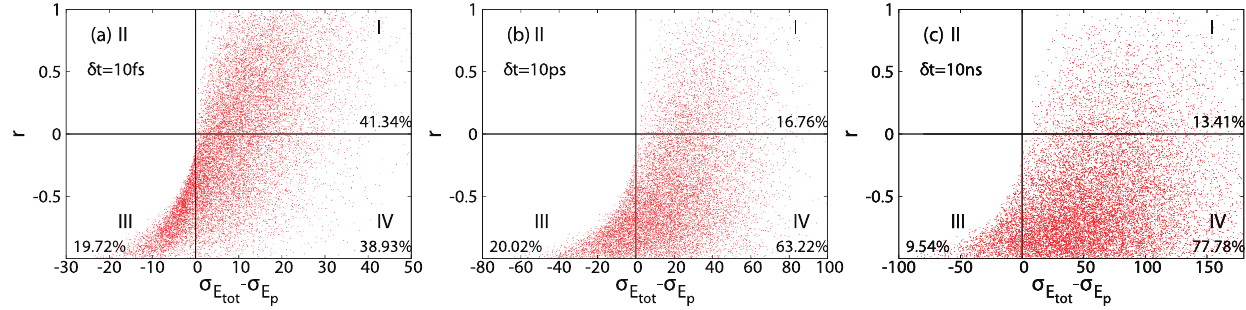
Figure 3. The relationship between r (correlation coefficient between E p and E p – w ) and net effects of water molecules on local PES { s ~ 10 fs , b) d t ~ 10 ps and c) d t ~ 10 ns . Data for all eight time scales studied are presented in Fig. S6. ( s E E p ) for three different time scales. a) d t tot